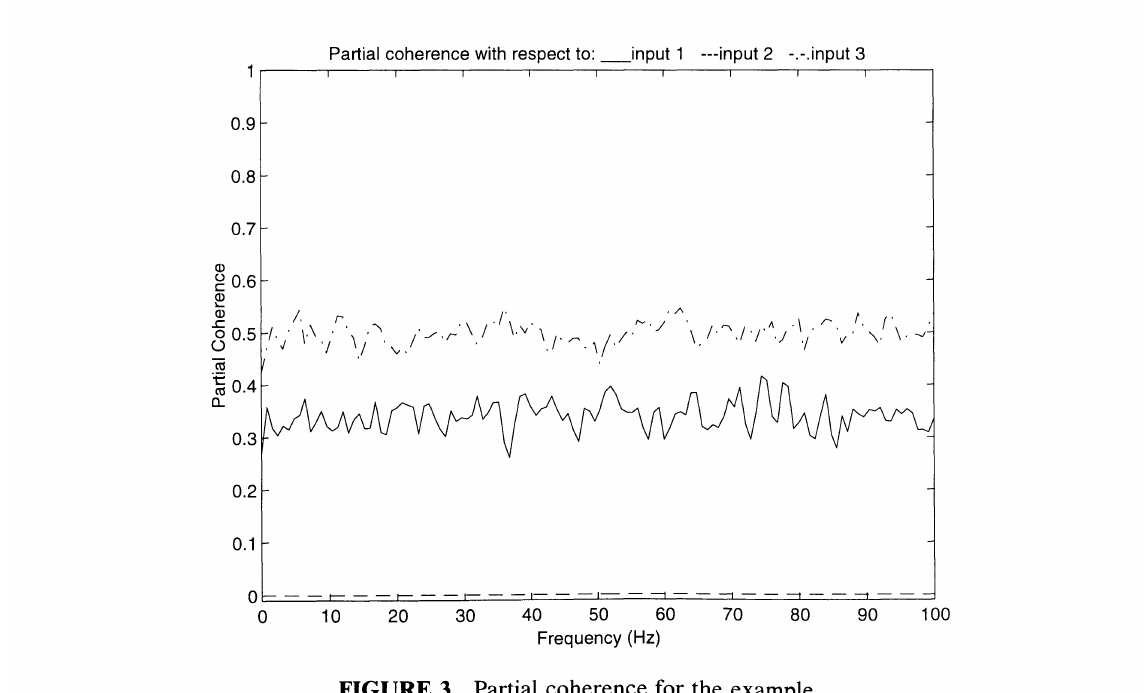
FIGURE 3 Partial coherence for the